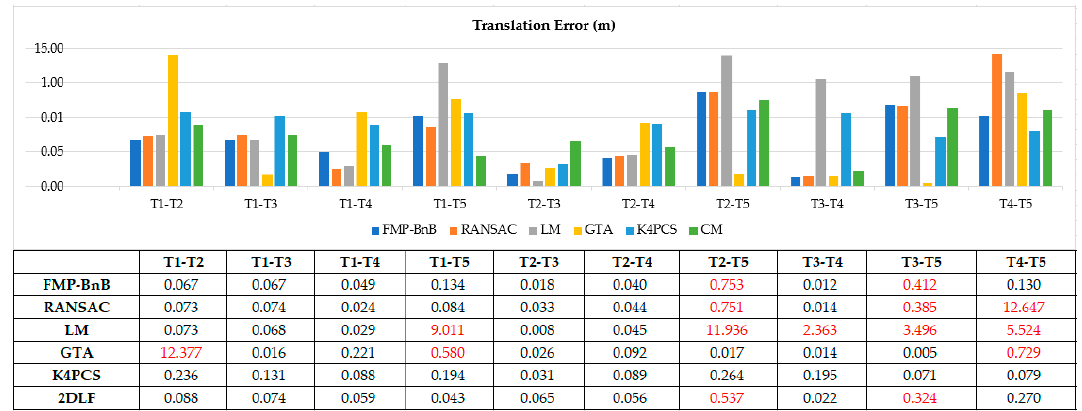
Figure 7. Translation error of pairs from dataset SR (the failed pairs are colored in red).